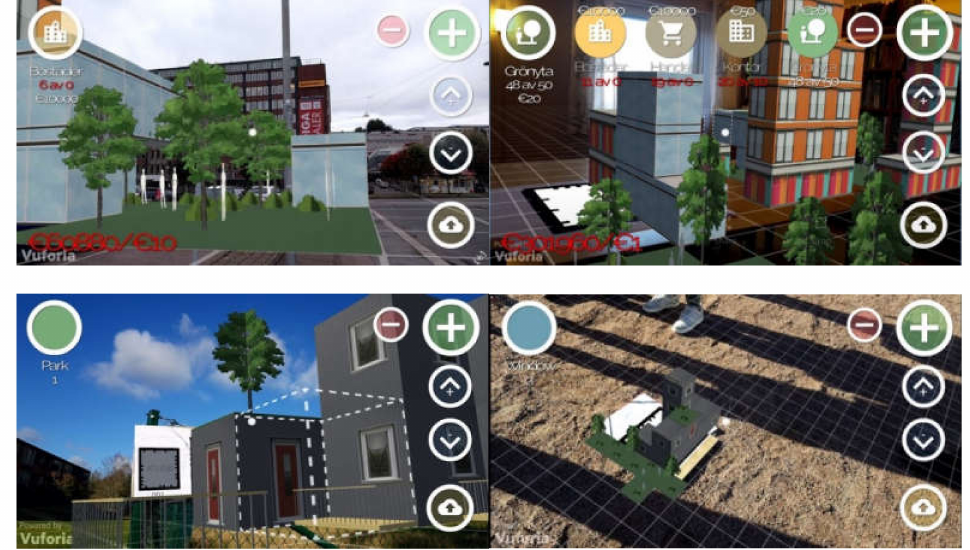
Figure 11. The images on the top row are from the test of P7, and the bottom row from the test of P8. The two images in the column to the left show the full-scale projection and the images in the column to the right the table-top scale